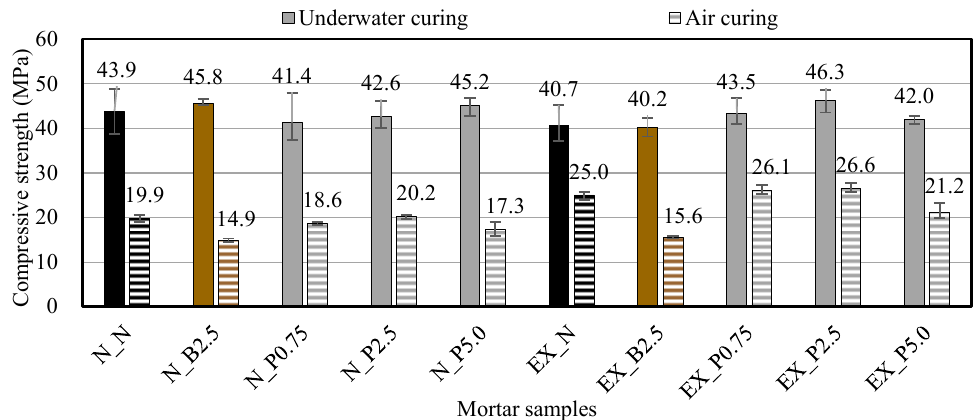
Figure 8. Compressive strengths of ordinary and expansive mortars at 28 days in the different curing conditions. (black: without NFBC, brown: with NFBC type B f , grey: with NFBC type P f )